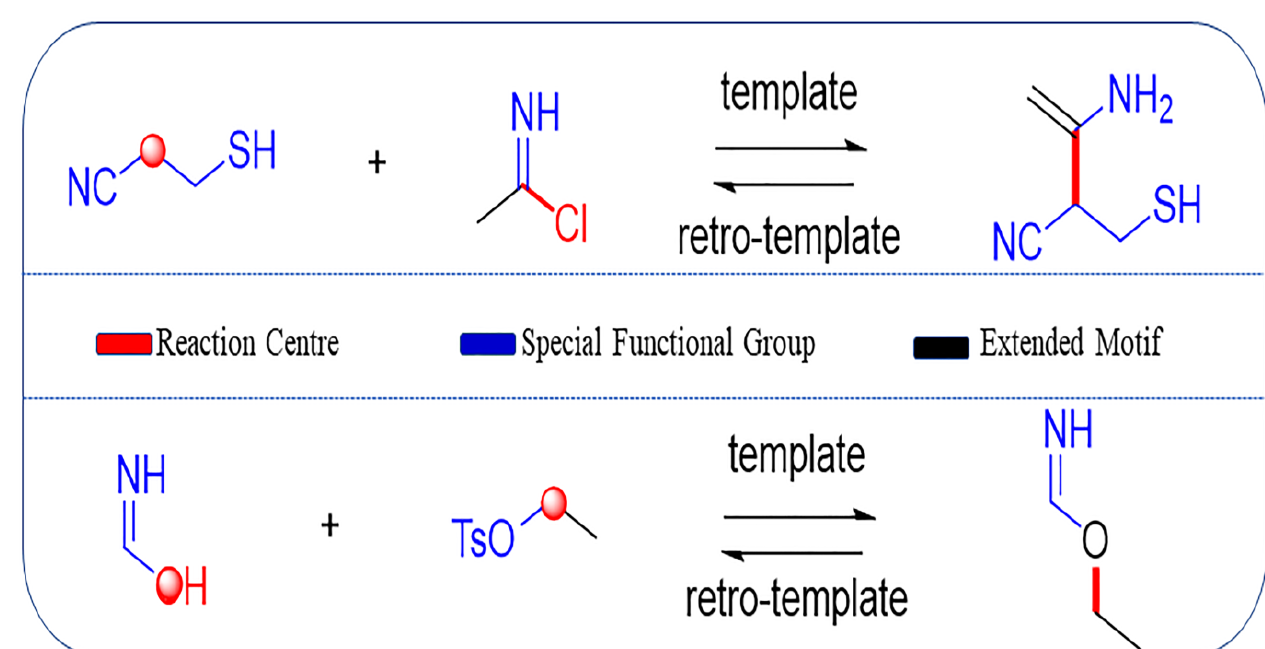
Figure 2. Examples of template extraction, in which colored sites are added to the reaction template. The red part refers to the reaction centers where the reaction occurs; blue part refers to the special functional groups around the reaction center; black part corresponds to the extended motif, which is the carbon atoms within a certain distance to the reaction center.